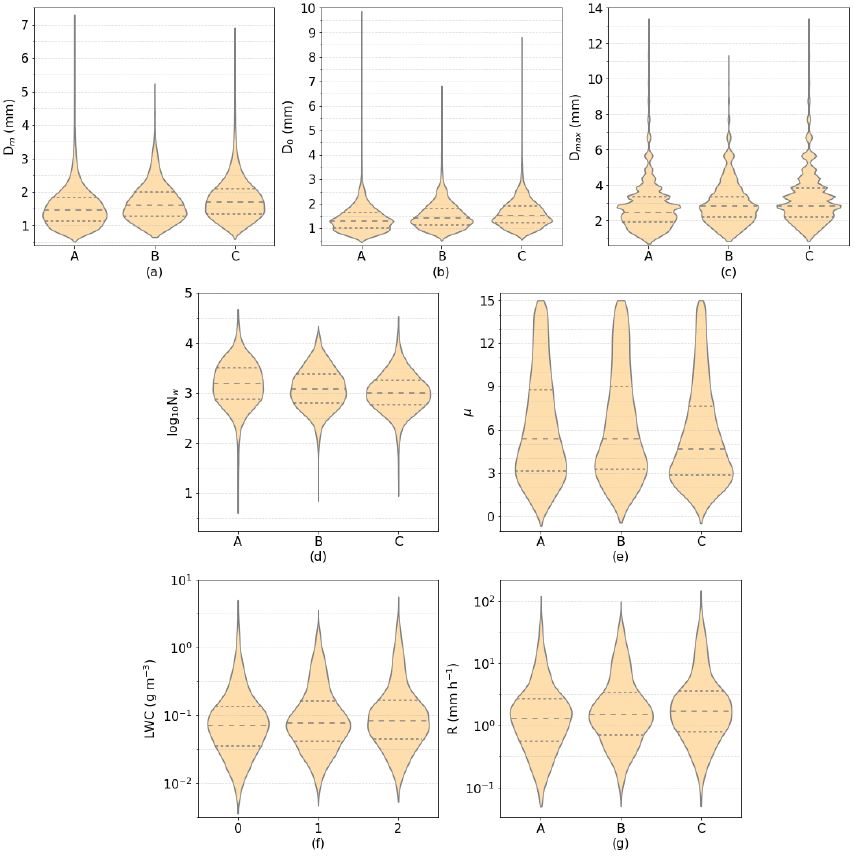
Figure 3. Violin plots of: ( a ) D m , ( b ) D 0 , ( c ) D max , ( d ) log N w , ( e ) µ , ( f ) LWC, and ( g ) R for the three study regions. The dashed line indicates the median, and the dotted lines indicate the first (P25) and third (P75) quartiles. The data were normalized so that each violin has the same area. Table 2. Statistics (mean, mode, standard deviation, min, max, P05, P95) of the different DSD parameters D m , D 0 , D max , log N w , µ , LWC, and R for each